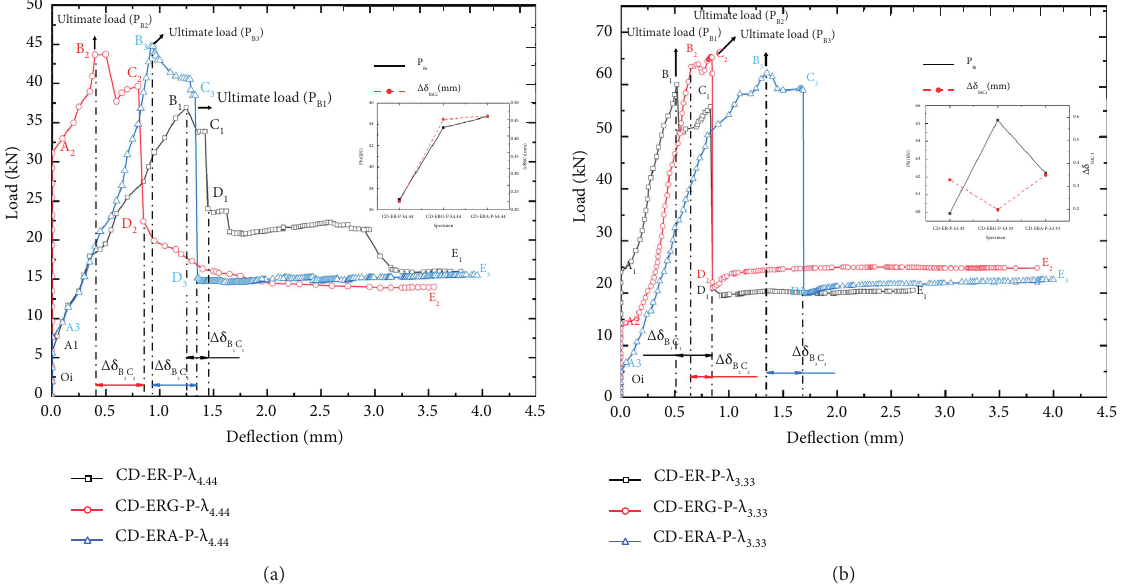
Figure 7: Load-deflection curves of specimens. (a) Ratio of shear span to depth ( λ 1 � 4.44). (b) Ratio of shear span to depth ( λ 2 �